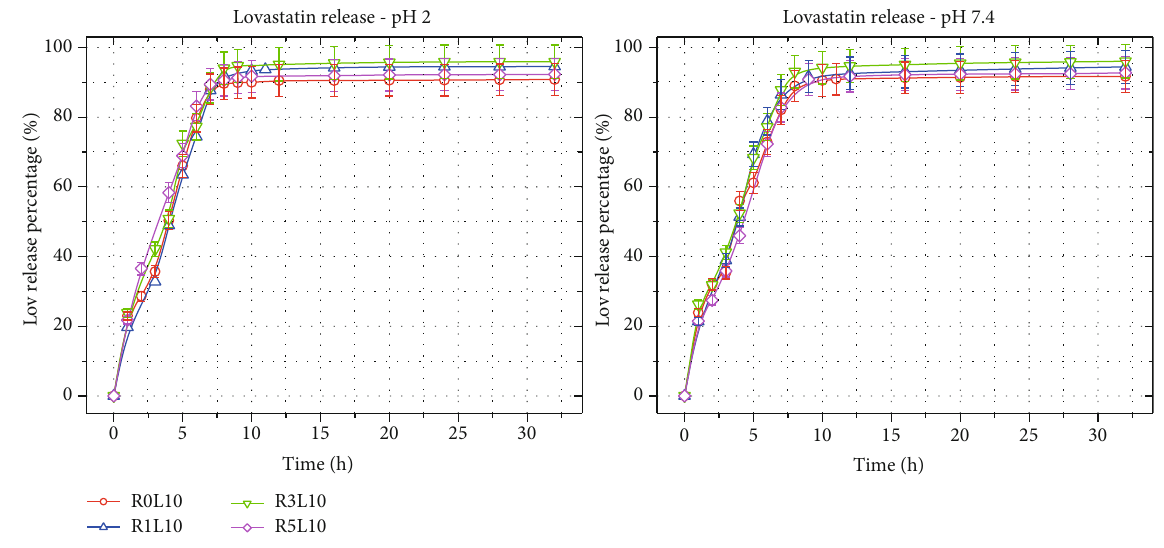
Figure 14: Percentage of Lov released from NPB – RxL10 samples in pH 2 and pH7.4